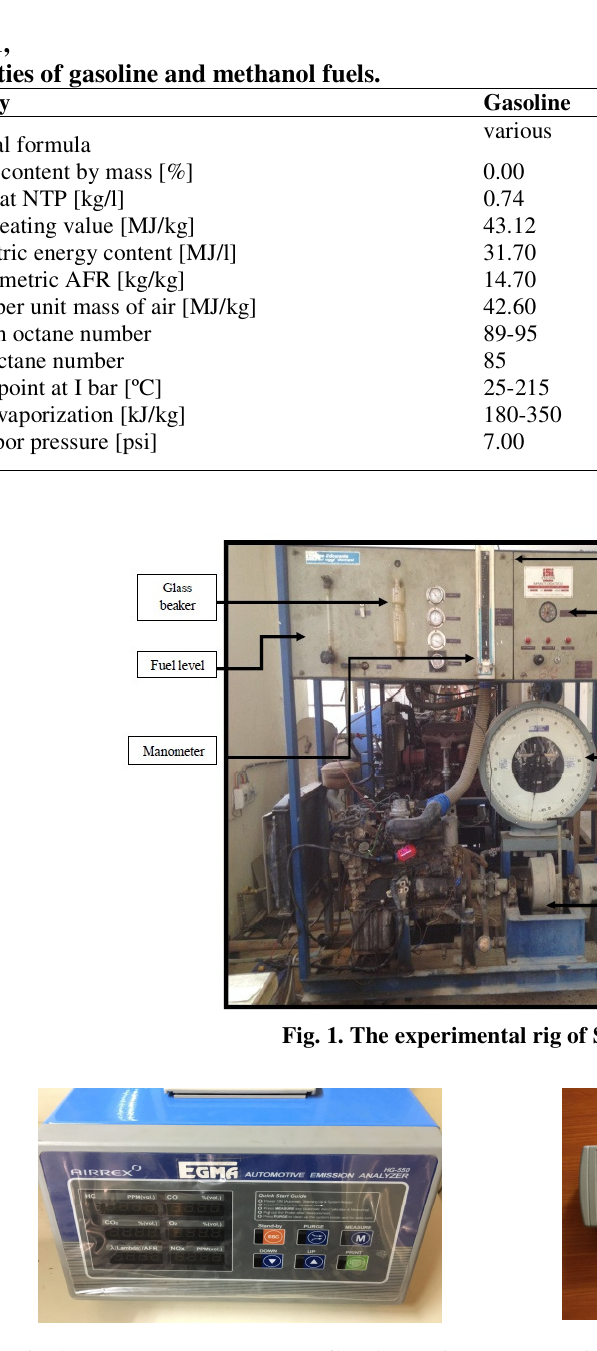
Fig. 3. The sound pressure level meter type SL-4010used in the tests